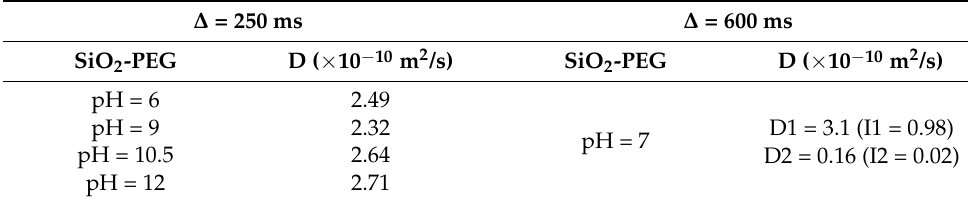
Table 1. Extracted diffusion coefficients of